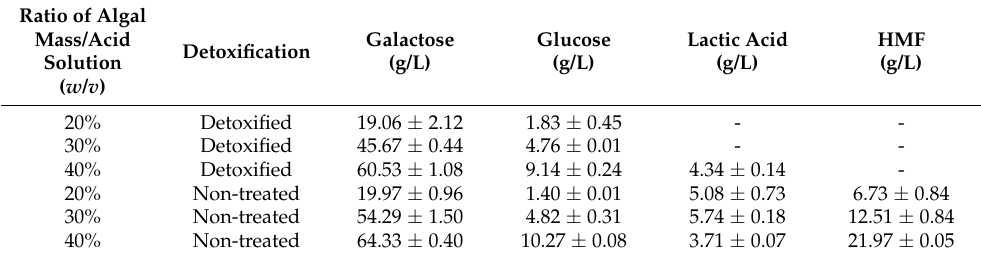
Table 2. Composition of detoxified and non-detoxified K. alvarezii hydrolysates.